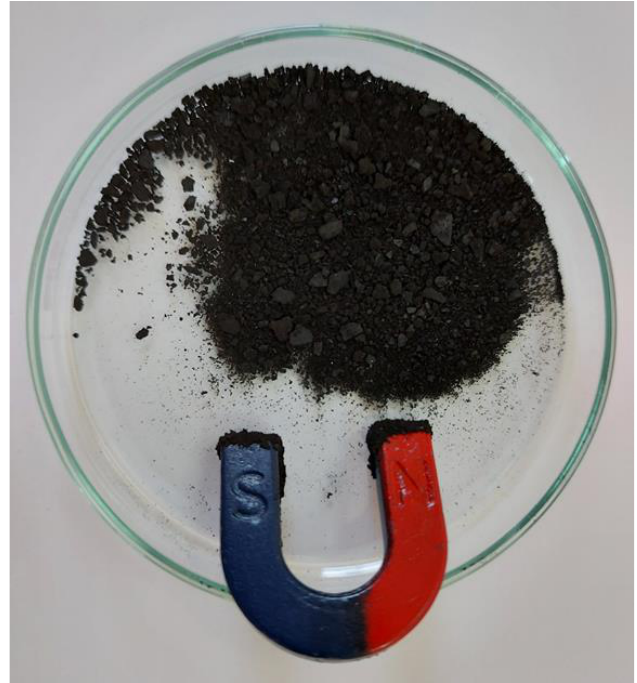
Figure 7. The magnetic properties of the ZnFe 2 O 4 -CNT adsorbent.